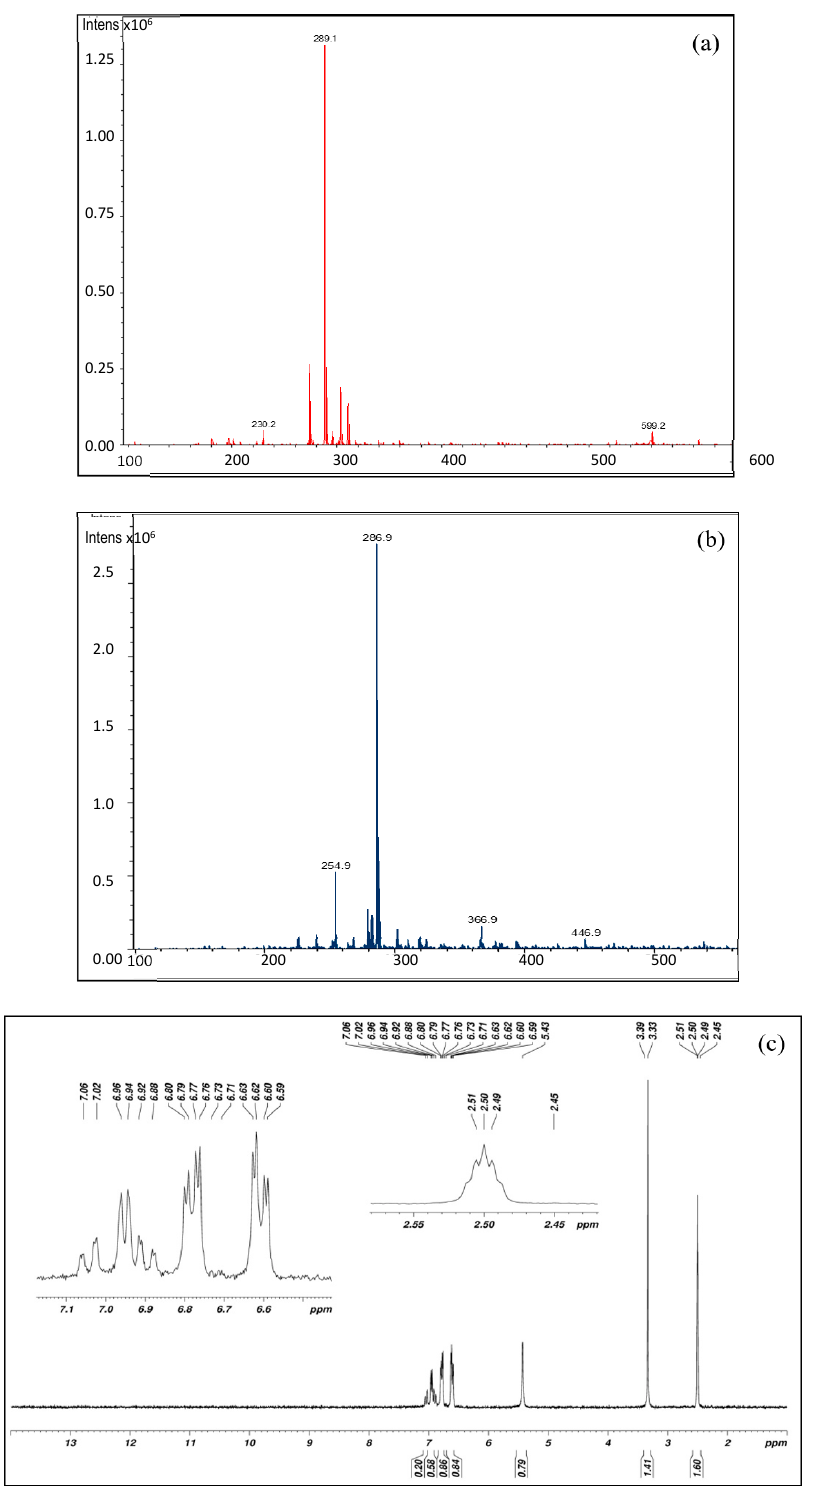
Figure 2. LC-MS spectra ( a ) MS + mode and ( b ) MS − mode, and ( c ) 1 H-NMR spectrum of the synthesized ACAT powder.